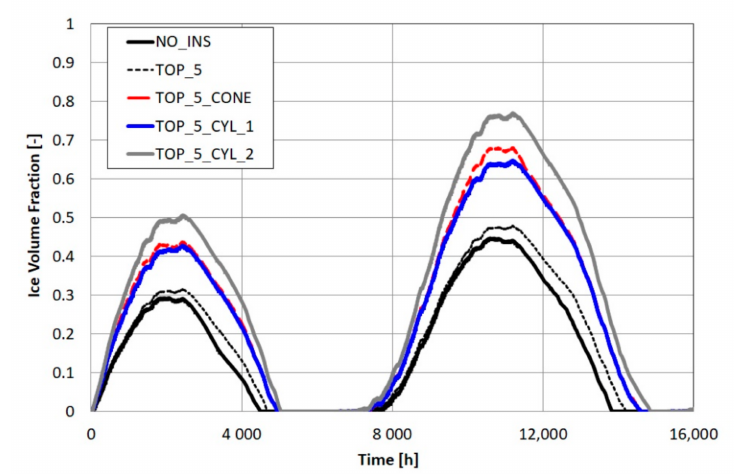
Figure 13. Ice volume fraction of the IT.